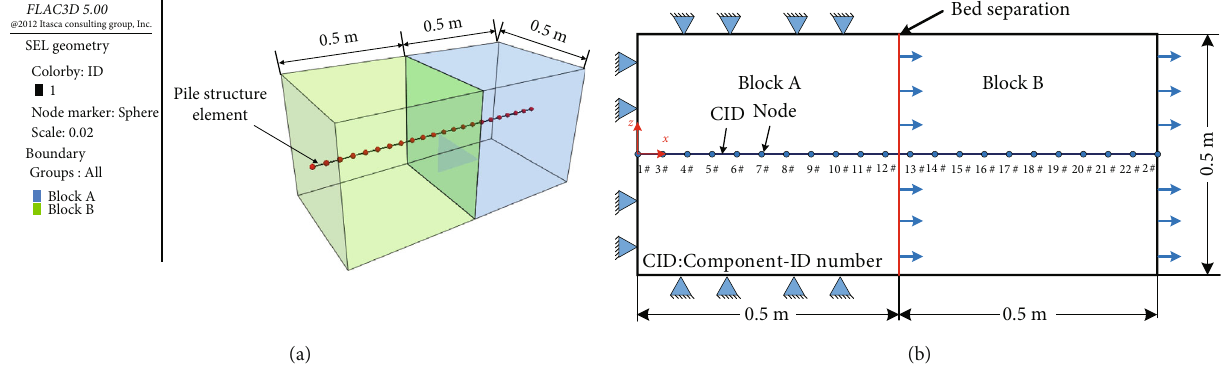
Figure 4: (a) Numerical simulation model diagram and (b) schematic diagram of boundary